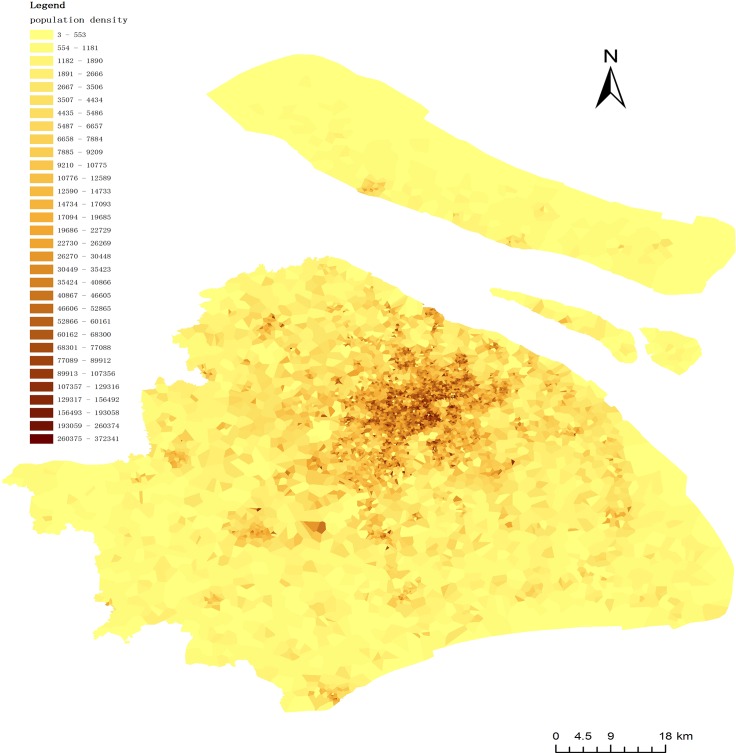
Population density.